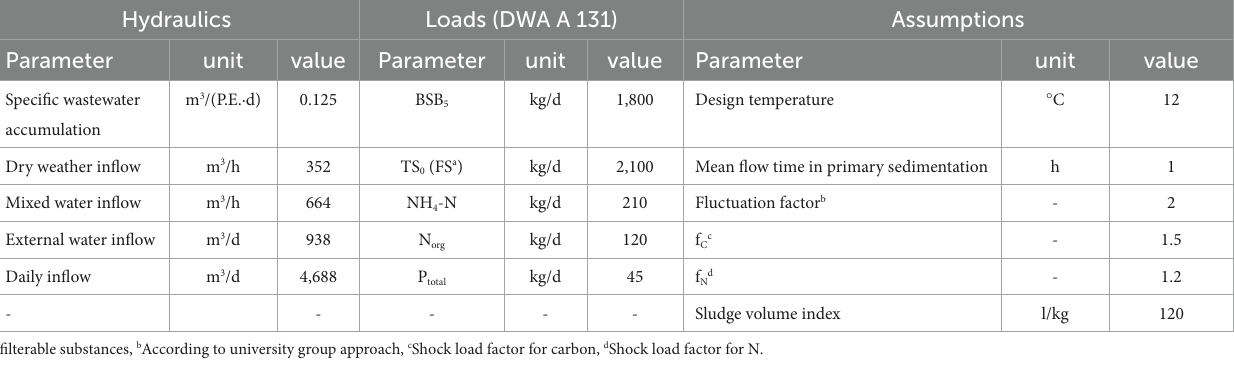
TABLE 3 Basis of assessment for the conventional wastewater treatment for 30,000 P.E.